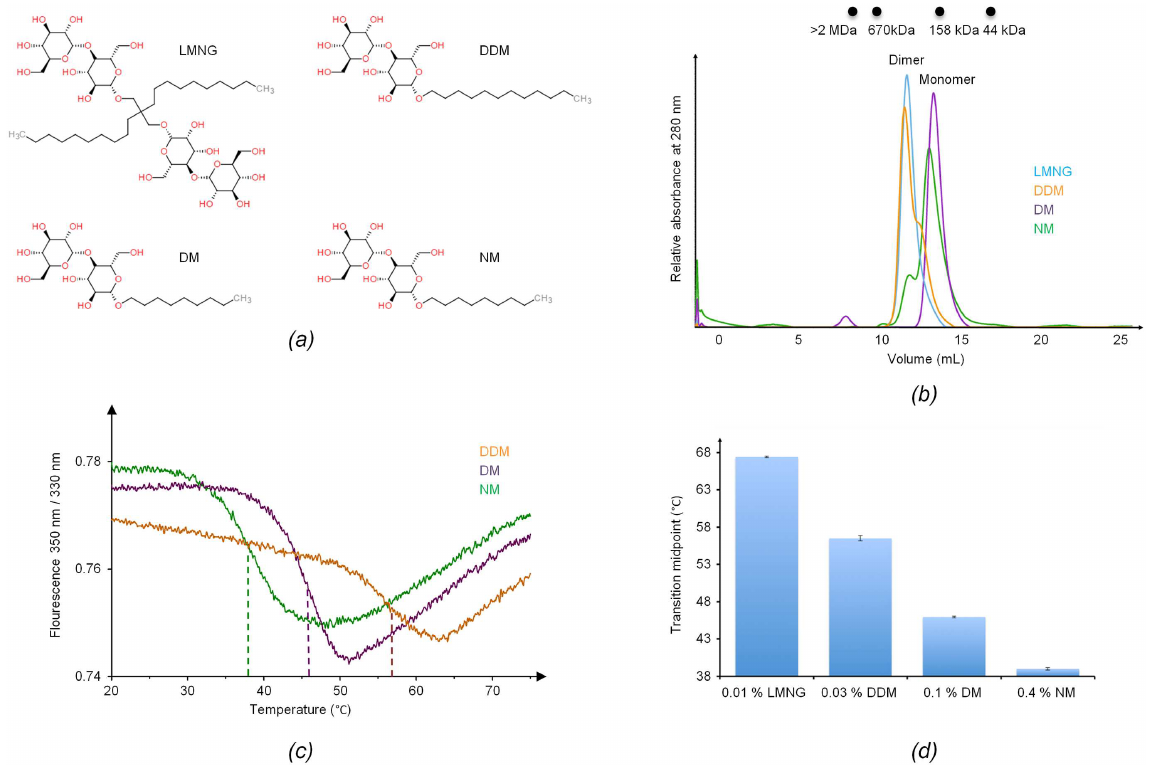
Fig 1. Detergent screening. (a) Chemical structures of the four different detergents used for purification: LMNG (Lauryl Maltose Neopentyl Glycol), DDM (n-Dodecyl- β -D-Maltopyranoside),DM (n-Decyl- β -D-Maltopyranoside), and NM (n-Nonyl- β - D-Maltopyranoside). (b) Size exclusionchromatography (SEC) profiles for PepT St purifiedin LMNG (blue), DDM (orange), DM (purple),and NM (green). (c) Differential scanningfluorimetry results. Thermal stability curves of the protein in the presenceof the detergents NM, DM and DDM are shown (same color code as in panel b ). The fluorescence ratio (F 350nm / F 330nm ) is representedas a function of temperature. Dashedlines indicate the meltingtemperatures (T m ). (d) Comparisonof the T m values for PepT St purifiedin different detergents. The error bars were calculatedfrom three